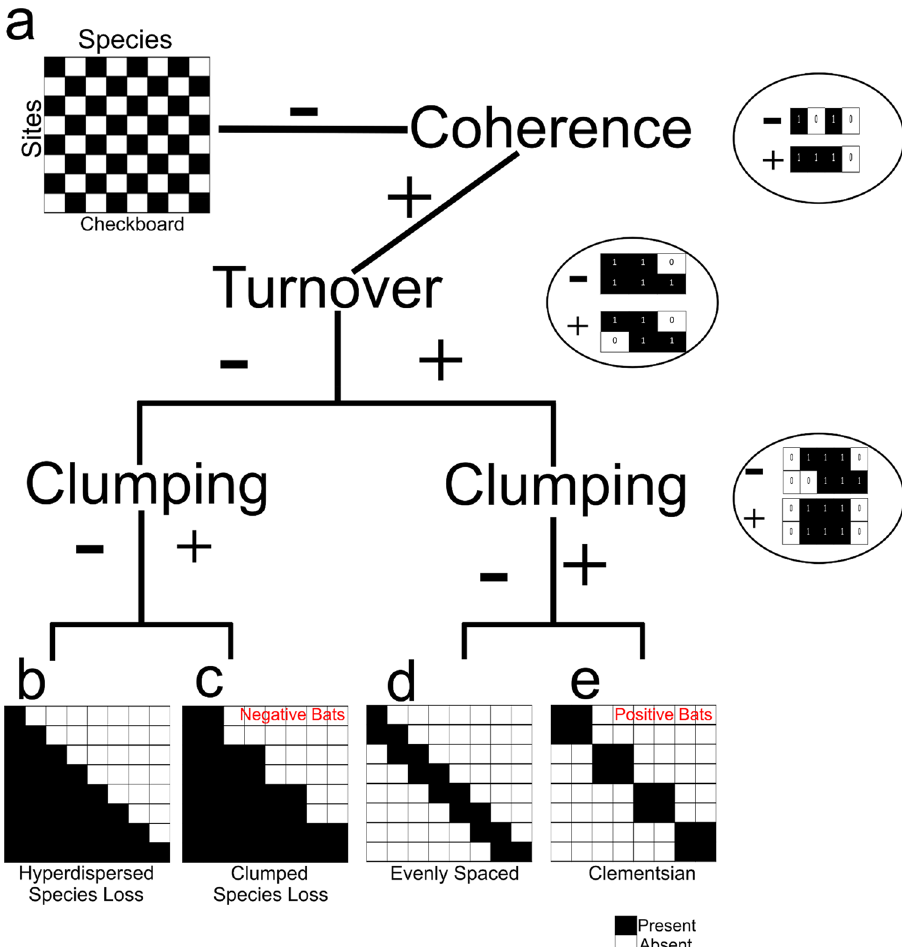
Figure 1. The elements of metacommunity structure and their resulting patterns. Plus signs ( +) indicate a significantly positive relationship, whereas minus signs ( −) indicate a negative relationship. ( a ) metacommunity with checkerboard pattern. ( b ) nested metacommunity with hyperdispersed species loss. ( c ) nested metacommunity with clumped species loss. ( d ) evenly spaced metacommunity. ( e ) Clementsian metacommunity structure. (Modified from reference 5 using the software Inkscape 1.0 www. inksc ape.